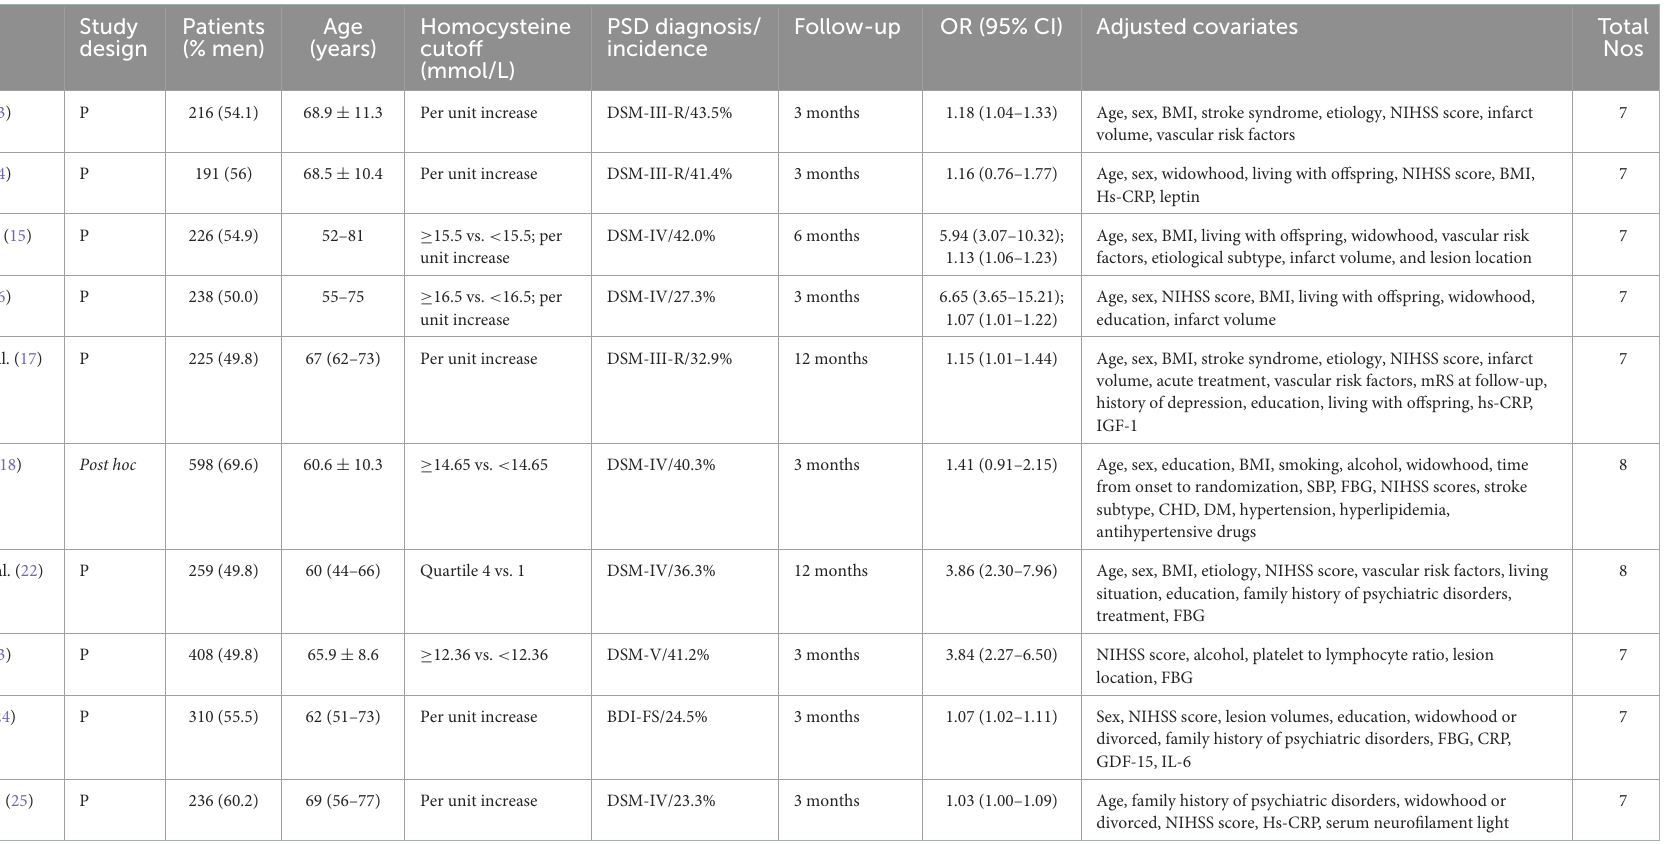
TABLE 1 Main characteristics of the included